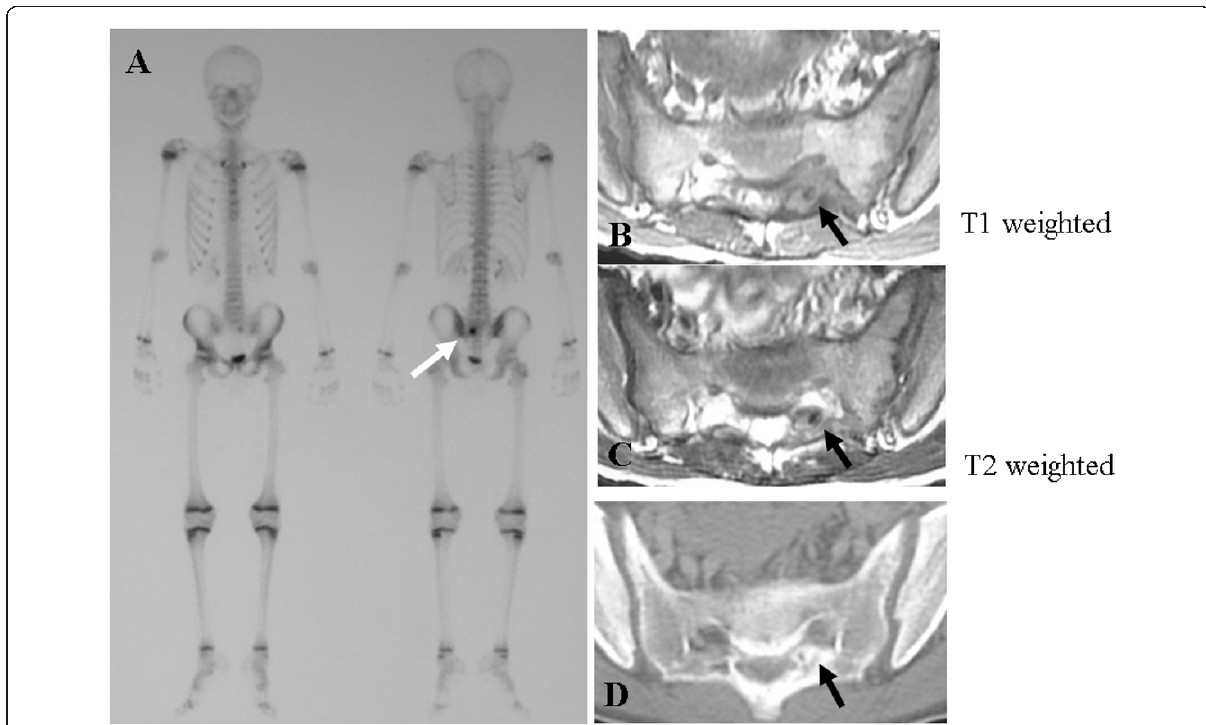
Figure 1 Technetium bone scan, MRI and CT . A; Technetium bone scan was useful in localizing the lesion. B, C; MRI revealed an intramedullary lesion, with isointense low signal on T1-weighted images and isointense high signal on T2-weighted images. D; Intense reactive sclerosis surrounding the nidus was seen on CT